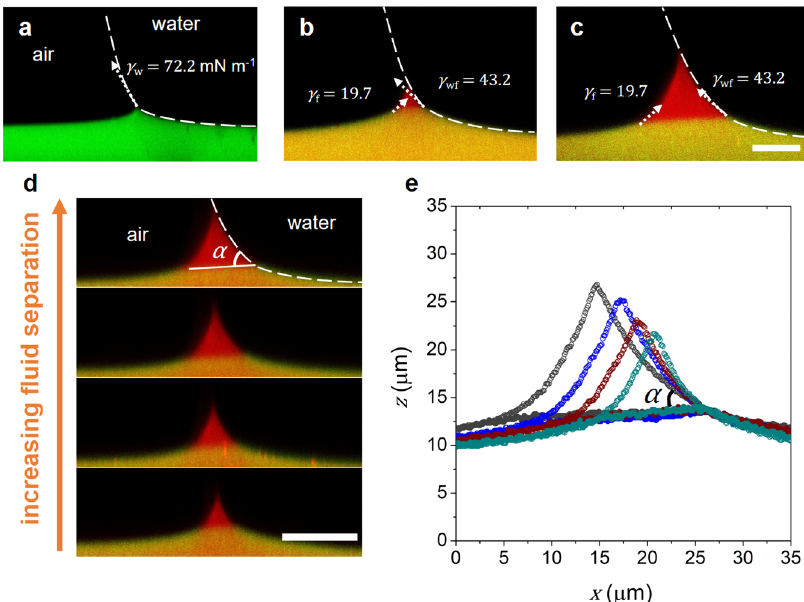
Fig. 6 Possible wetting ridge height mechanisms. Confocal images show the surface/interfacial tensions pulling up the network for ( a ) dry, ( b ) low swelling ratio, and ( c ) high swelling ratio 60:1 samples. d Cross-sectional confocal images of four 50:1 samples with different levels of swelling and fl uid separation, and ( e ) the corresponding pro fi les aligned at the network- fl uid-water contact line on the right side. Interfacial tensions are shown as vectors with magnitude given in mN m − 1 . Scale bar: 20 µ